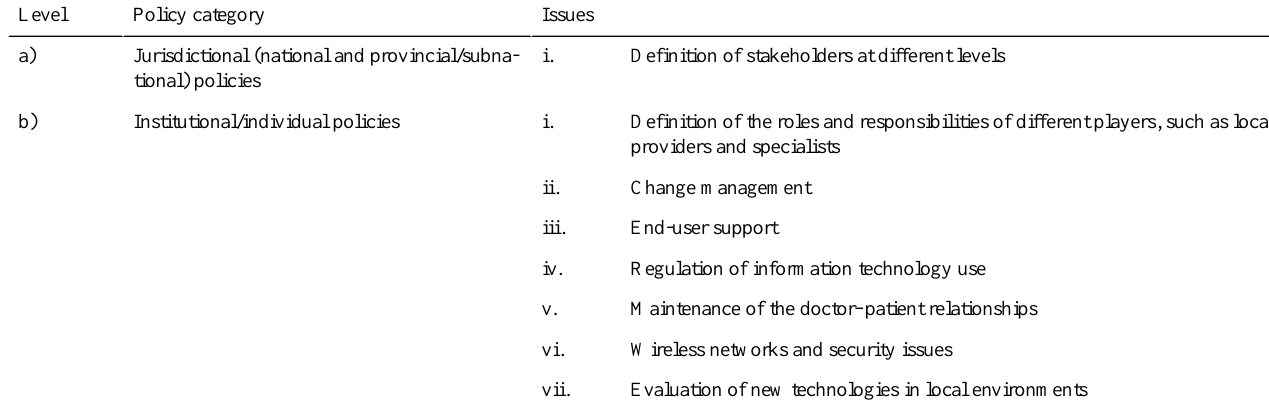
Table 5. Response to new